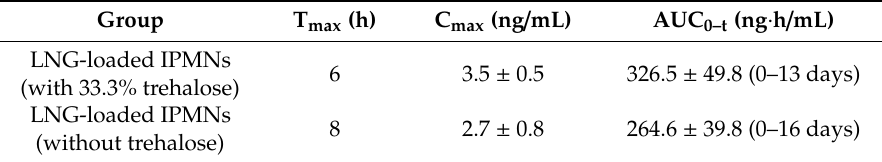
Table 1. Pharmacokinetic parameters of plasma LNG concentrations after administration of LNG- loaded IPMNs with 33.3% trehalose and without trehalose in vivo in rats (mean ± s.d., n = 6). Peak plasma concentration (C max ), the time when C max was reached (T max ), and the area under the plasma concentration versus time curve from time zero to the time of the last detection (AUC 0–t ).